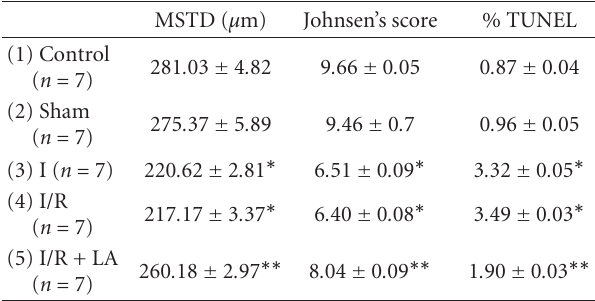
Table 1: The e ff ect of ischemia-reperfusion (2h torsion 720 ◦ in a clockwise direction and 2 h detorsion of the testis) and LA (100mg/kg ip, 30 minutes prior to detorsion) on MSTD, Johnsen’s score and germ cell